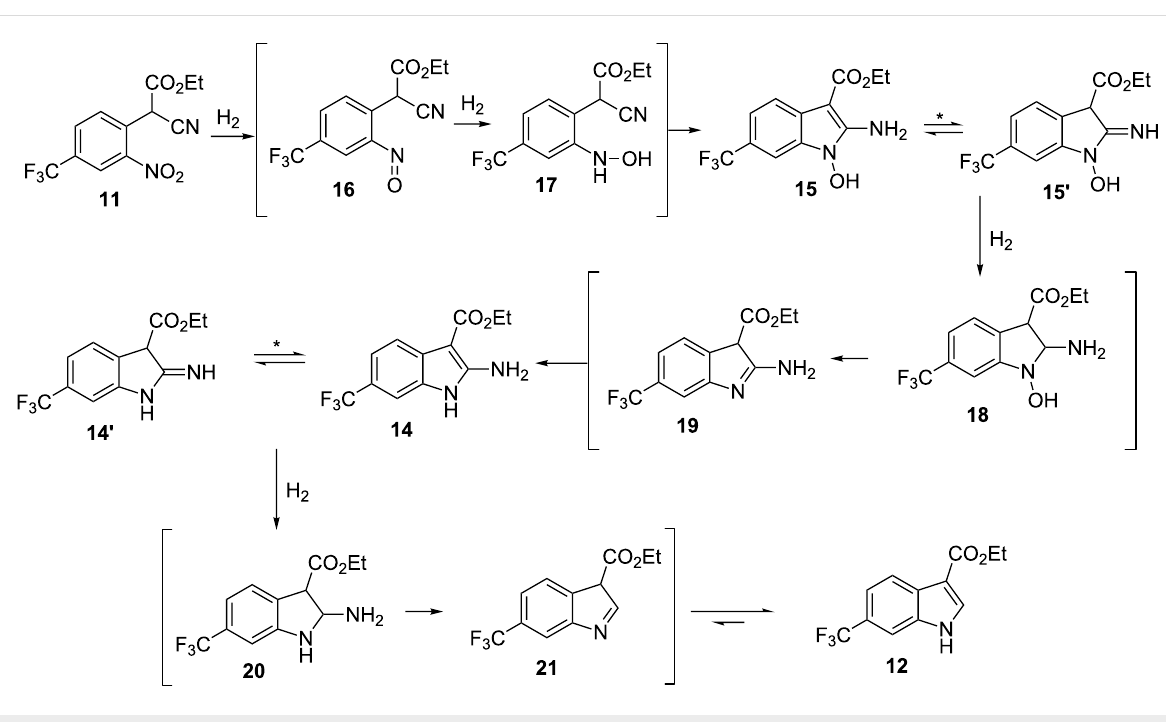
Scheme 5: Stepwise reduction of intermediate 11 under hydrogenation conditions. * Indicates potential tautomeric structure. Species in parentheses are proposed transient